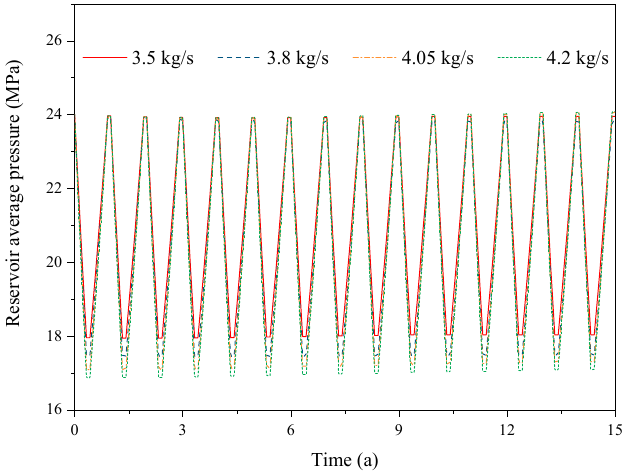
Figure 24. Reservoir average pressure for different production rates.